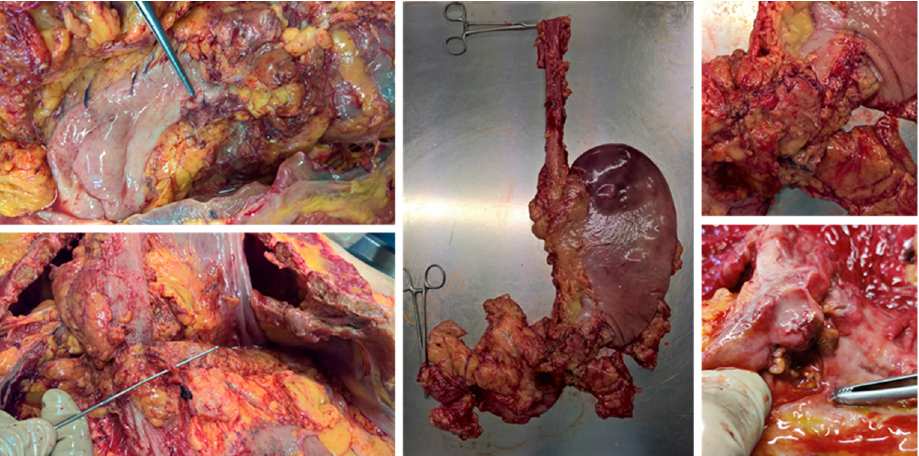
Figure 1. Autopsy investigation on case no. 17. Surgical treatment of bleeding duodenal ulcer and erosion of the superior pancreaticoduodenal artery. Evidence of correct surgical hemostasis.